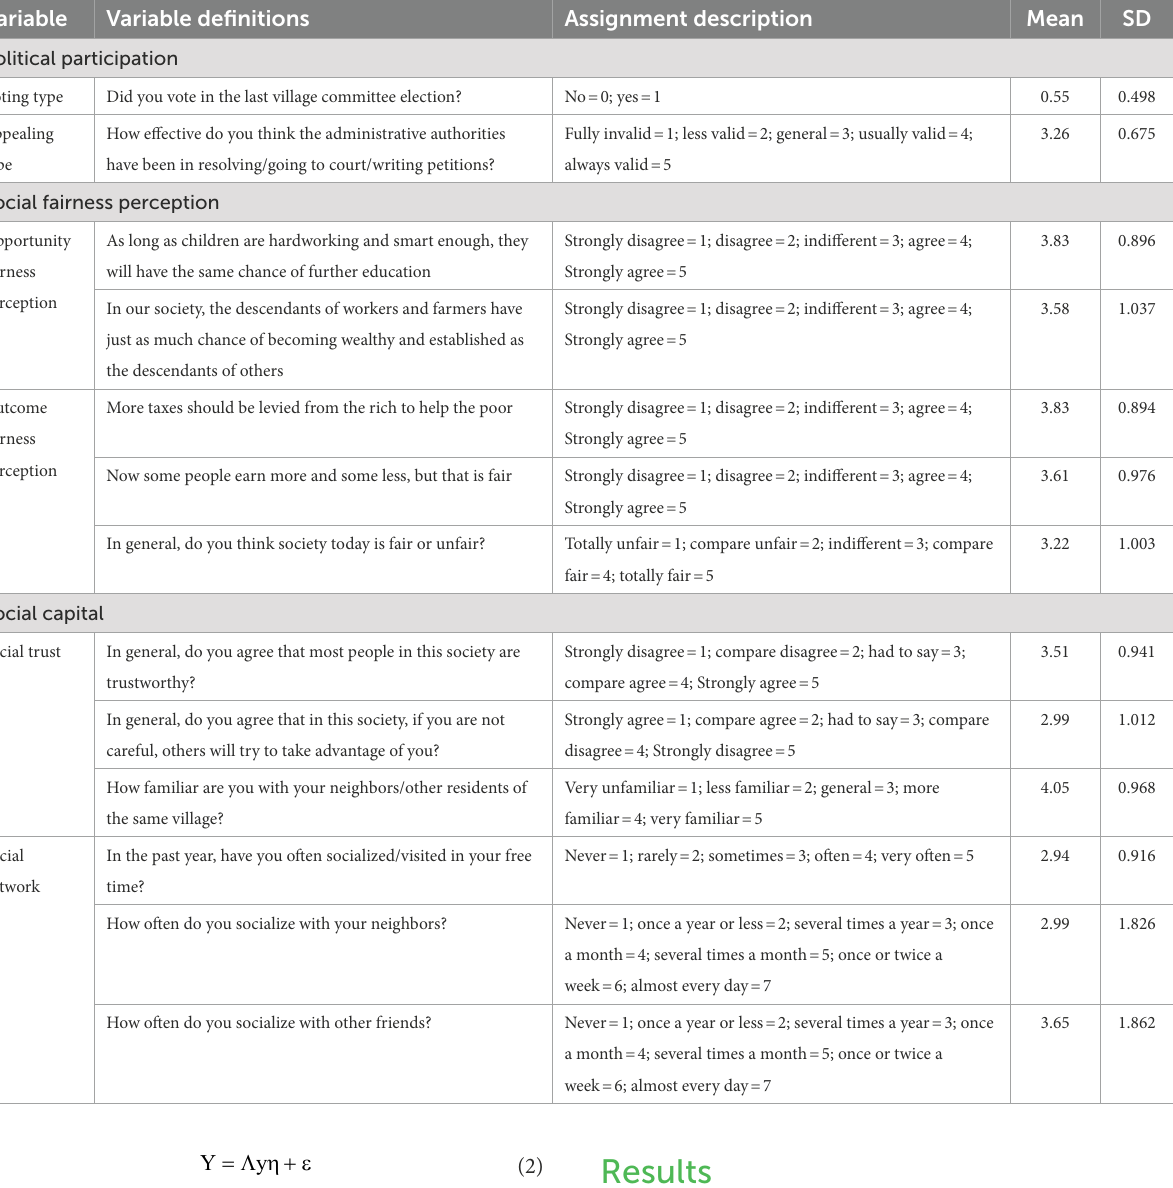
TABLE 2 Meaning, assignment, and description of variable operational